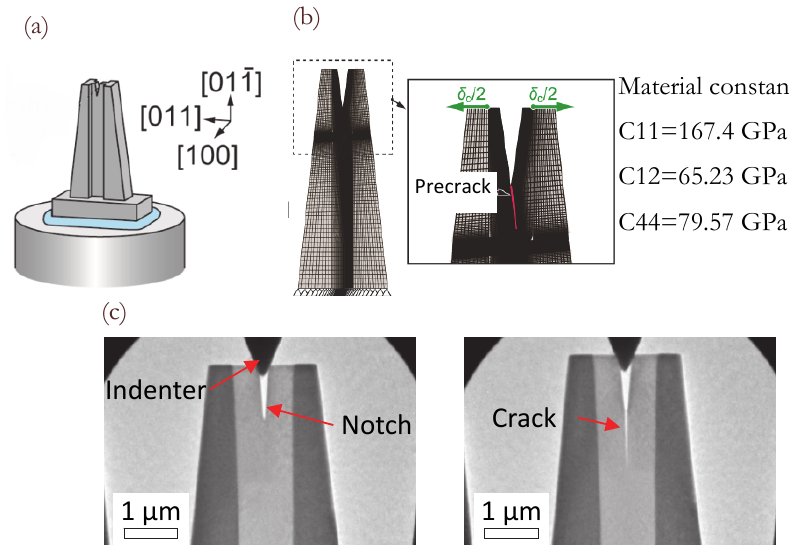
Figure 2: Example of (a) nanoscale notched specimen, (b) 3D FE model and (c) introduction of pre-crack.